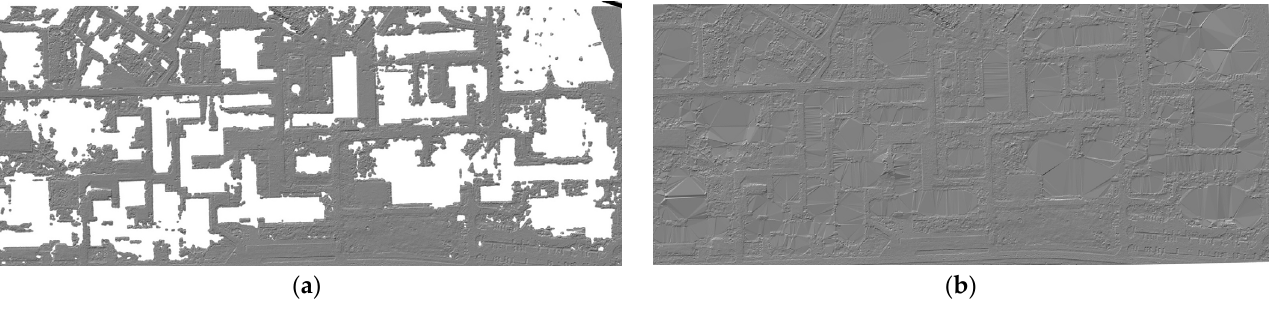
Figure 10. ( a ) DTM in raster format with void pixels, ( b ) final DTM obtained with two interpolation methods: Kriging and Delaunay triangulation.